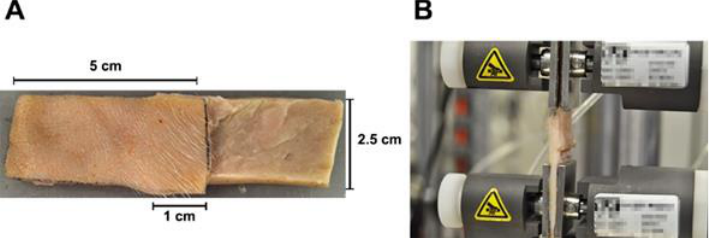
Figure 1. Adhesion strength assay. ( A ) Samples of porcine skins glued with FGs or commercial FG, indicating its dimensions (5 cm length, 2.5 cm width, and 1 cm overlap) according to the ASTM manual F2255–05 [25]. ( B ) Adhesion strength test. ASTM: American Society for Testing and Materials; FG: bio-based fibrin glue.